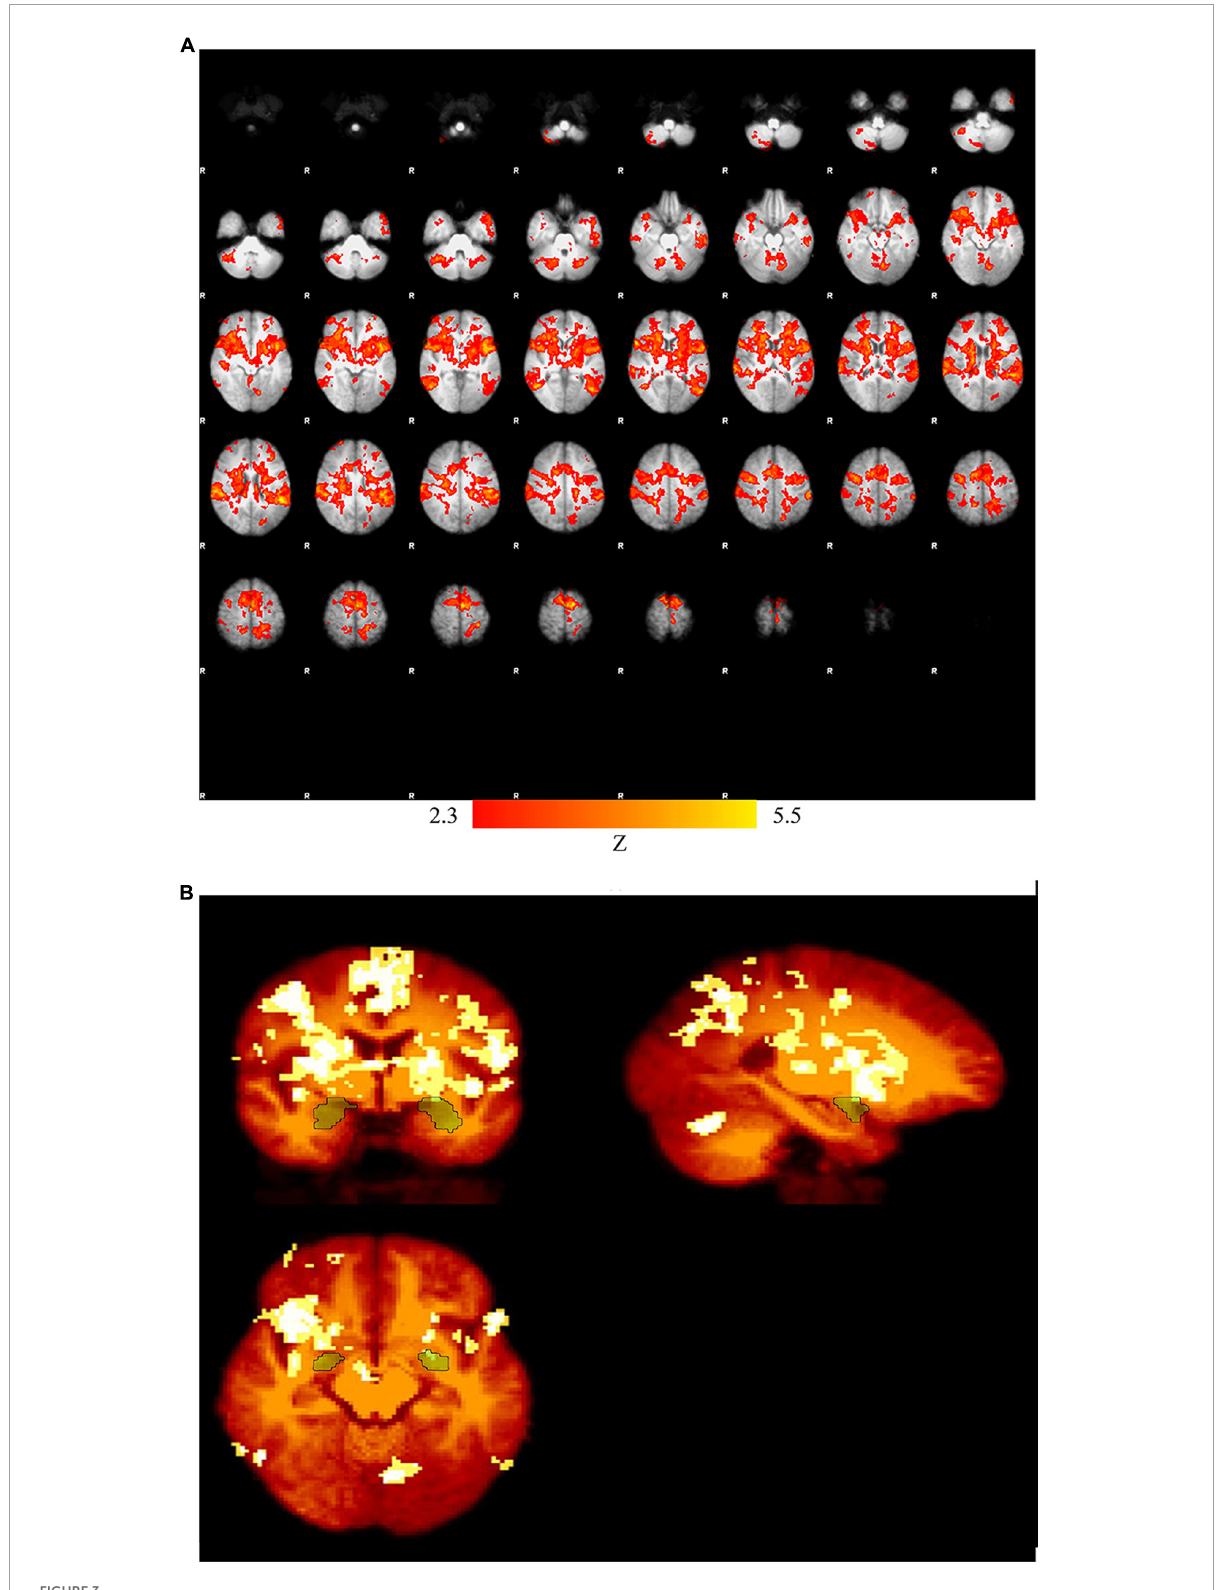
FIGURE3 (A) Activation map for Upregulation versus View in the experimental group (p corrected = 0.01), (B) activation map masked by